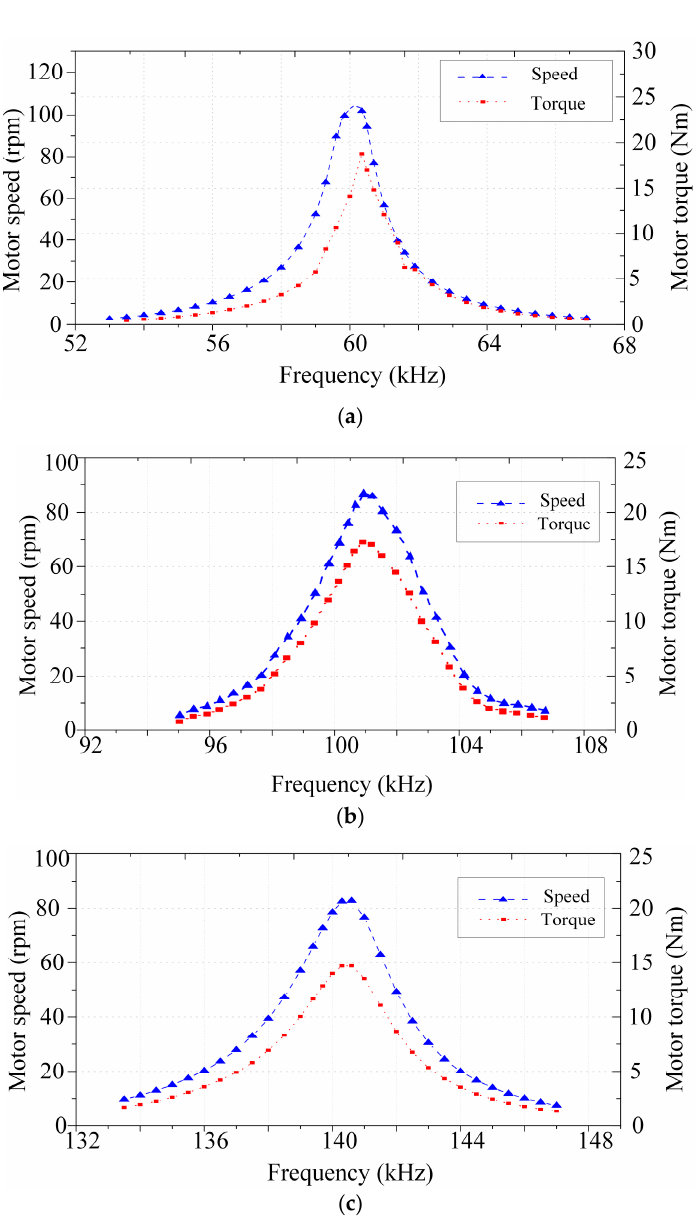
Figure 7. Motor speed regulation by frequency control: ( a ) motor 1; ( b ) motor 2; and ( c ) motor 3.